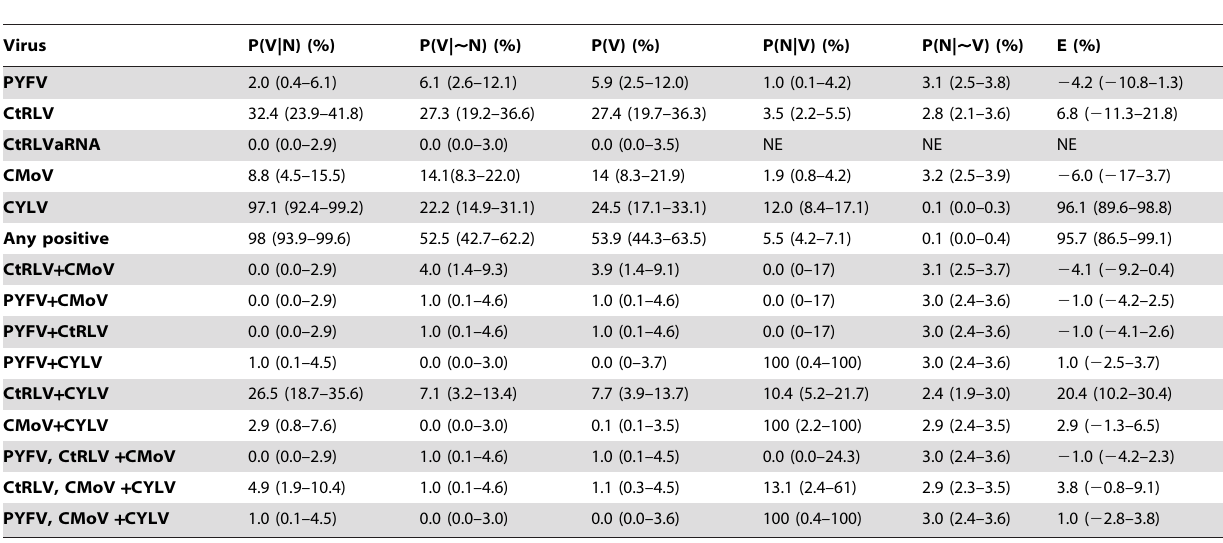
Table 2. Estimates of prevalence of virus and necrosis and the effect of virus removal on reducing necrosis (values in brackets are 95% confidence